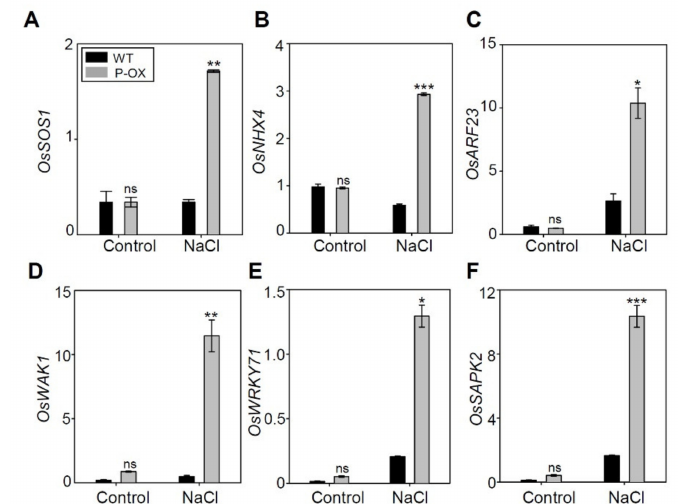
Figure 10. qRT-PCR of candidate genes involved in salt stress tolerance. ( A – F ) qRT-PCR amplification of genes from the root tissues of WT and OsEXPA7 -OX plants, sampled 0 and 2 h after salt treatment. OsSOS1 ( A ), OsNHX4 ( B ), OsARF23 ( C ), OsWAK1 ( D ), OsWRKY71 ( E ), and OsSAPK2 ( F ) were tested. The OsAct11 expression level was used as a control. qRT-PCR analysis was performed with at least three biological replicates. Asterisks indicate a statistically significant di ff erence, as determined by